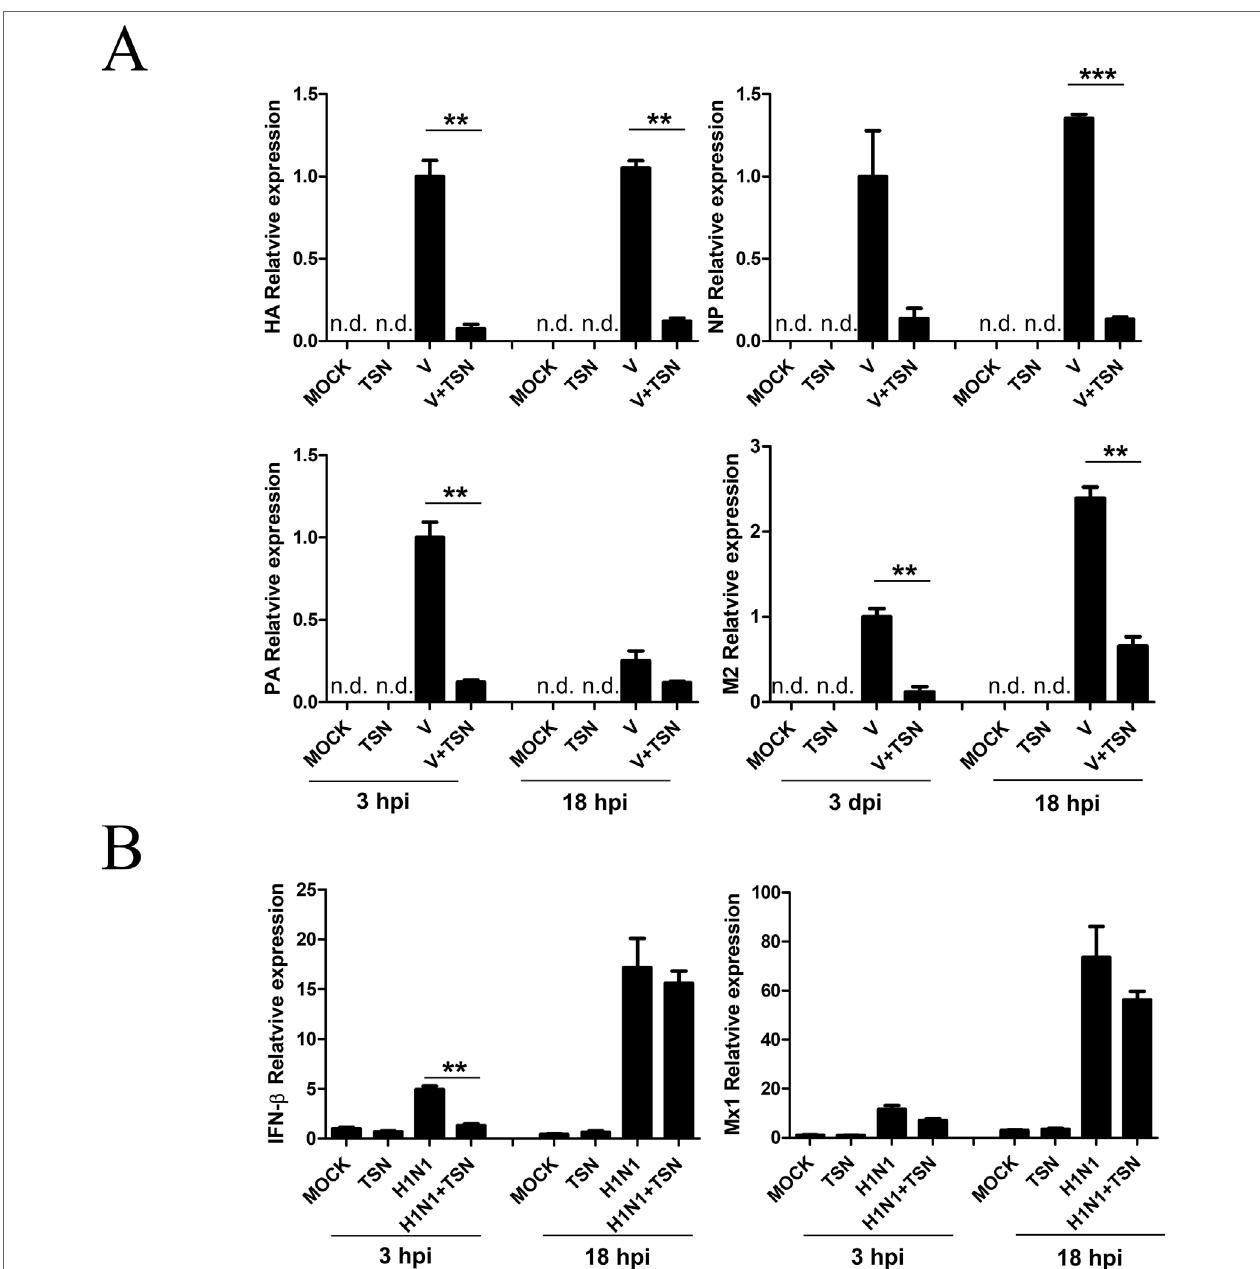
FIGURE 5 | TSN pretreatment decreased synthesis of influenza virus A/PR/8/34 mRNA but did not affect the antiviral host response. (A) MDCK cells were pretreated with TSN (2 µM) as described then infected with 10 MOI A/PR/8/34. Expression levels of HA, NP, PA, and M2 viral mRNAs were assessed by qRT-PCR. (B) Host expression levels of IFN- β and Mx1 were assessed at 3 and 18 hpi by qRT-PCR. Expression levels were normalized to β -actin mRNA. Data are presented as mean ± SD of three replicates and are representative of three independent experiments (n.d., not detected). V, control virus-infected MDCK cells. Statistical significance was analyzed by Student’s t -test. ** P < 0.01; *** P <